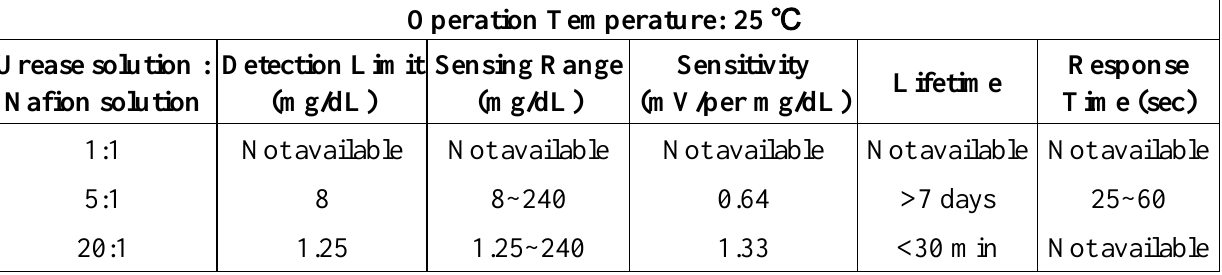
Table 1. The urea responses and performance of sole urease biosensors with different ratio of urease